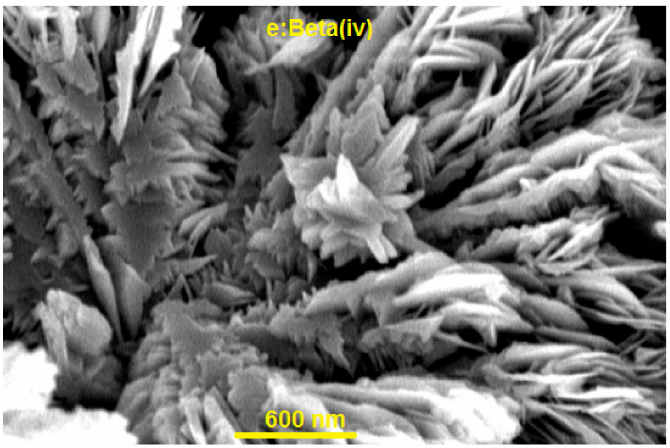
Figure 3. Scanning electron microscopy (SEM) images of the investigation effect of different SDA on the Beta-zeolite supports synthesized with ( a ) without SDA, ( b ) TPAOH, ( c ) tetrapropylammonium bromide (TPABr), ( d ) morpholine, ( e ) n -butylamine.